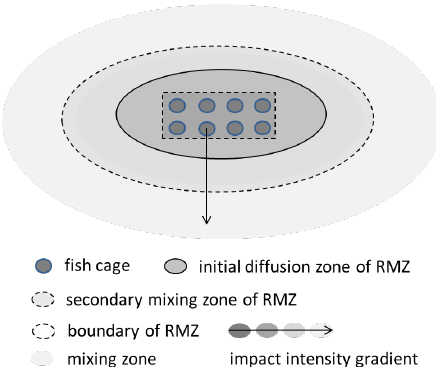
Figure 4. Schematic diagram of the regulatory mixing zone (adapted from Scottish Environment Protection Agency, SEPA [84]).